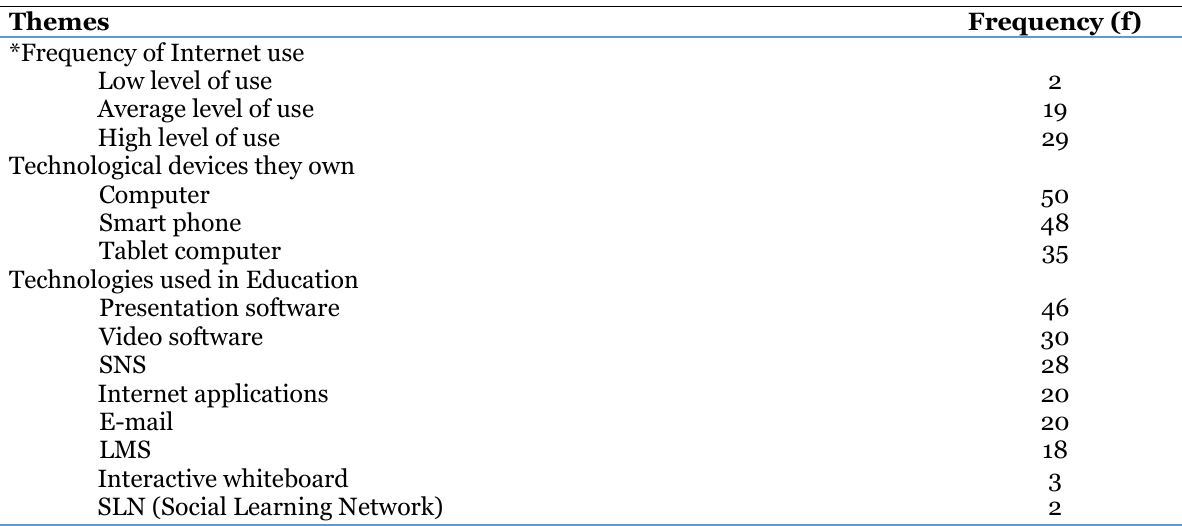
Table 2 Findings Regarding General Use of the Internet and SNS